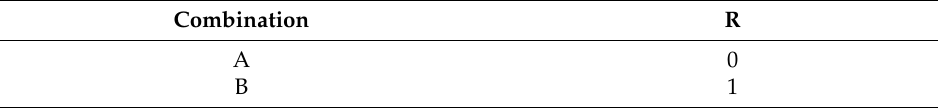
Table 4. Regulator combinations (“1”: Active, “0”: Not present).